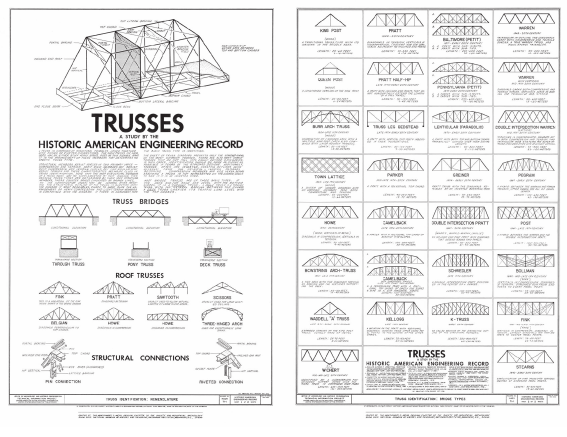
Figure 2: Lattice Trusses